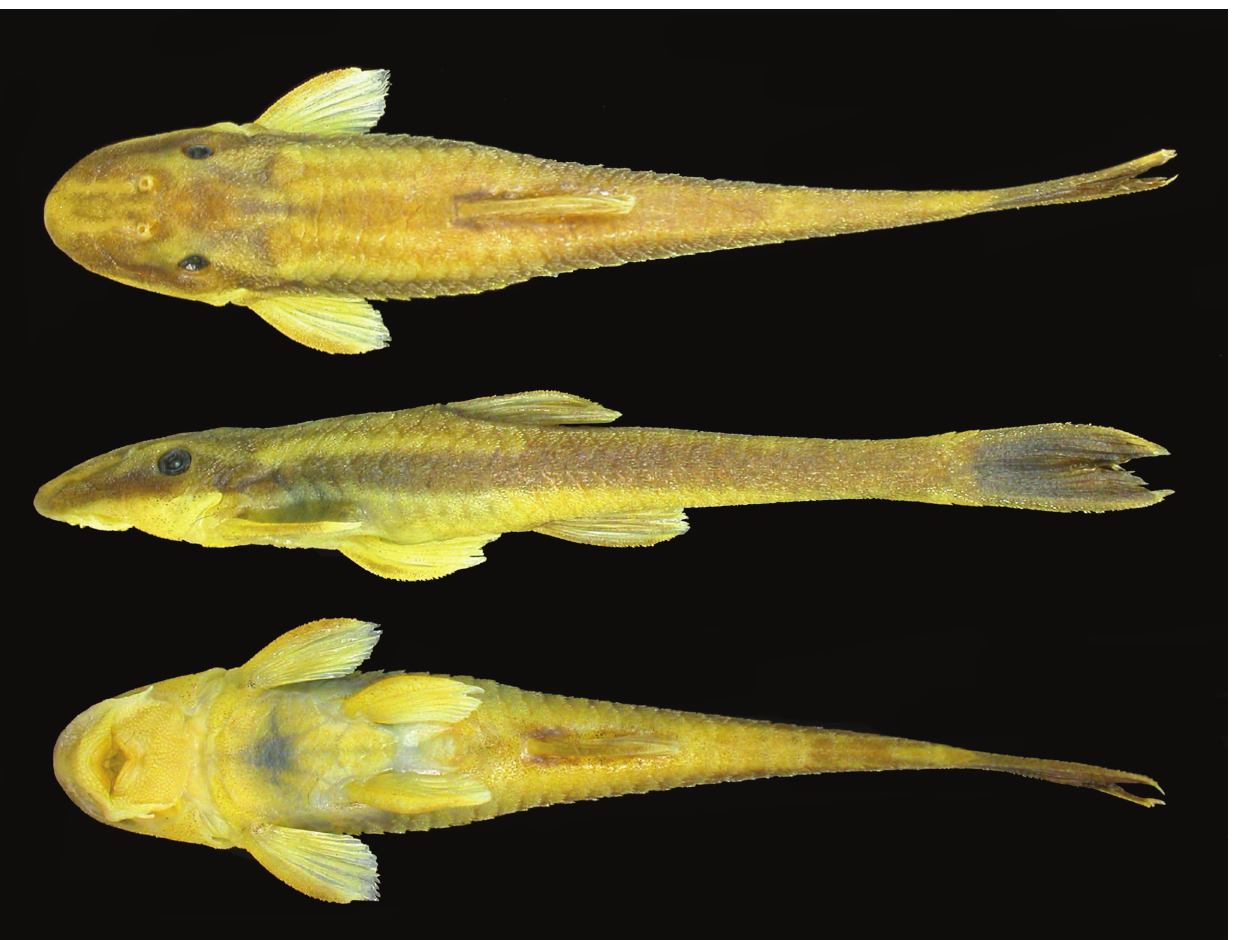
Fig. 1. Microlepidogaster longicolla , holotype, MCP 44877, female, 39.8 mm SL. Brazil, Distrito Federal, Brasília, ribeirão Santana, tributary to rio São João, on road from Cidade Ocidental to Brasília. Head and snout broad, snout rounded in dorsal view.